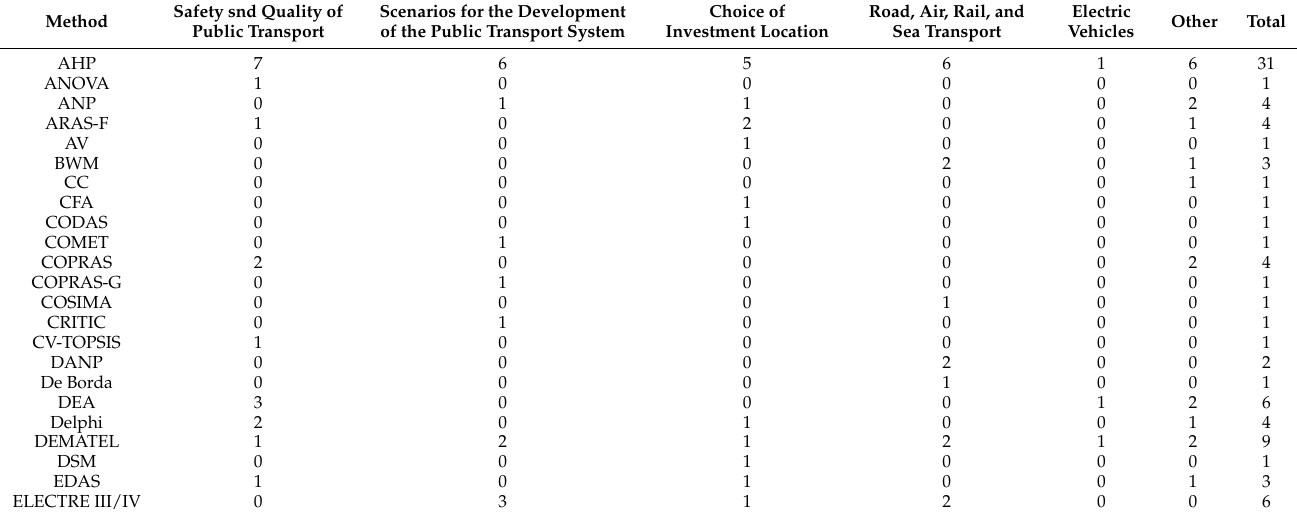
Table A2. Summary of the methods’ application in selected areas associated with transport infrastructure in 2000–2021.